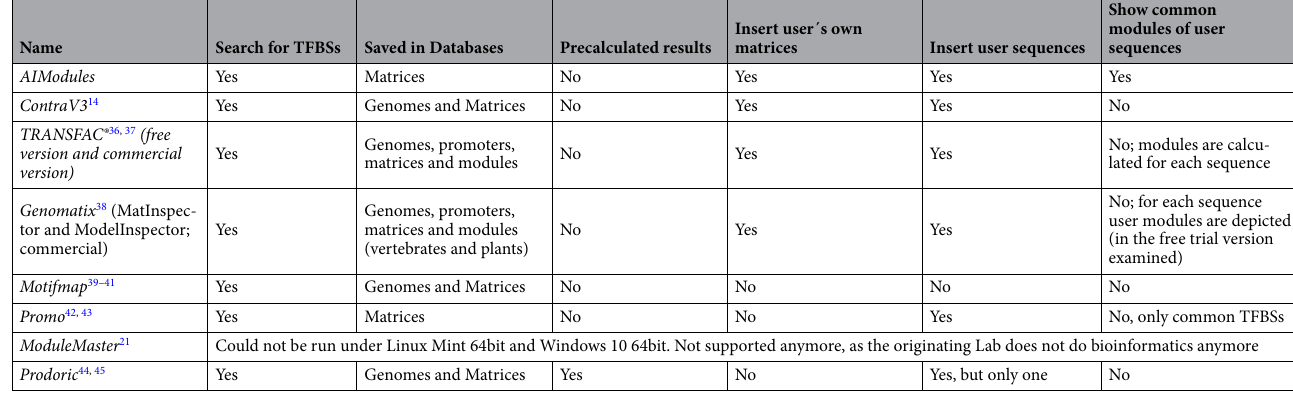
Table 3. Comparison of promoter analysis